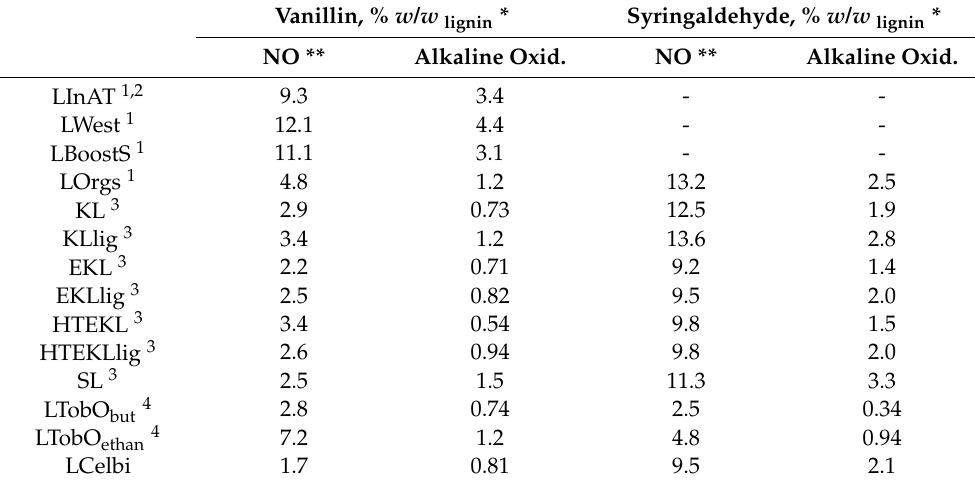
Table 1. Yields of vanillin and syringaldehyde obtained by nitrobenzene oxidation (NO) and alkaline oxidation using O 2 of lignins studied at LSRE (experimental conditions of alkaline oxidation using O 2 and performed in reactor batch: T i = 120 ◦ C; [lignin] = 60 g/L; [NaOH] = 80 g/L; pO 2 = 3 bar; p t = 9.8